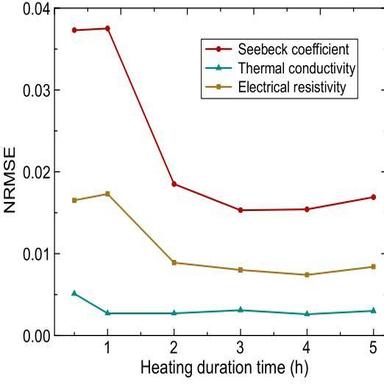
The impacts on the accuracy of the characterized parameters from the heating rates using the QSS method.